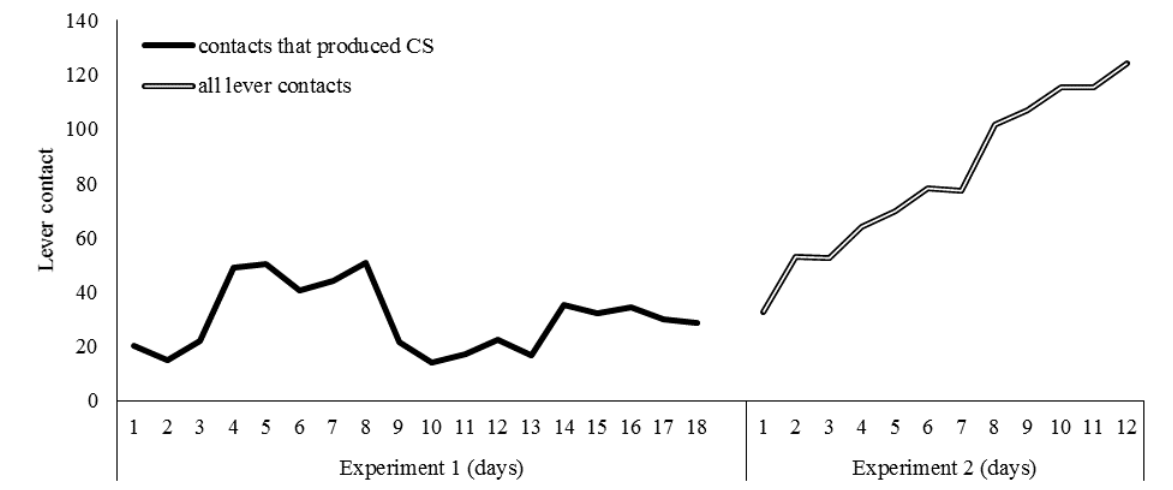
Figure A1. Lever contact over sessions from Experiments 1 and 2. Although presented together here for comparison, the data of these two experiments are not directly comparable for several reasons. First, the sessions were notably longer in duration in Experiment 1 than 2. Second, for Experiment 1, these data are actually just showing the number of self-produced presentations, and so only a conservative estimate of the lever contact of only Group INT